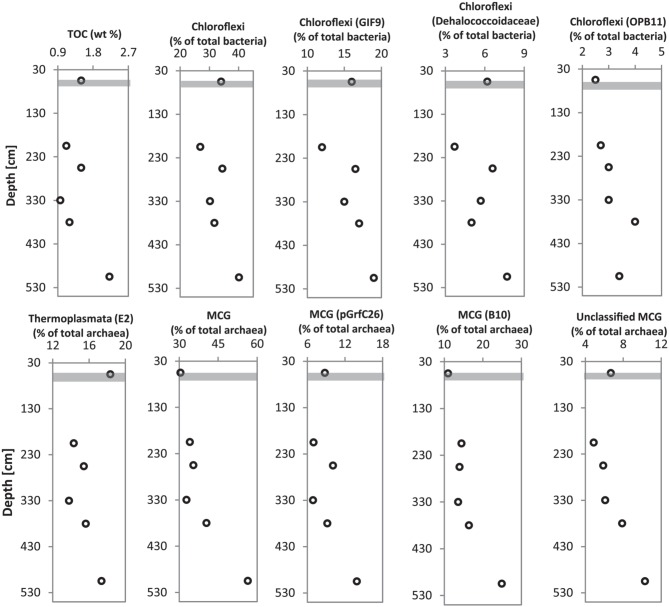
Depth profiles of dominant Bacteria (Chloroflexi) and Archaea (Thermoplasmata and MCG) in relation to TOC content at sediment depths from which DNA was extracted for pyrosequencing analysis of 16S rRNA genes. Gray bar represents SMT.